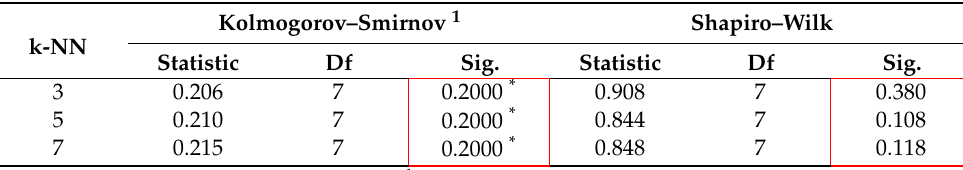
Table 7. Results of the normality test with the k value as 3, 5, and 7 (prediction success rate of pinch gesture for each subject).